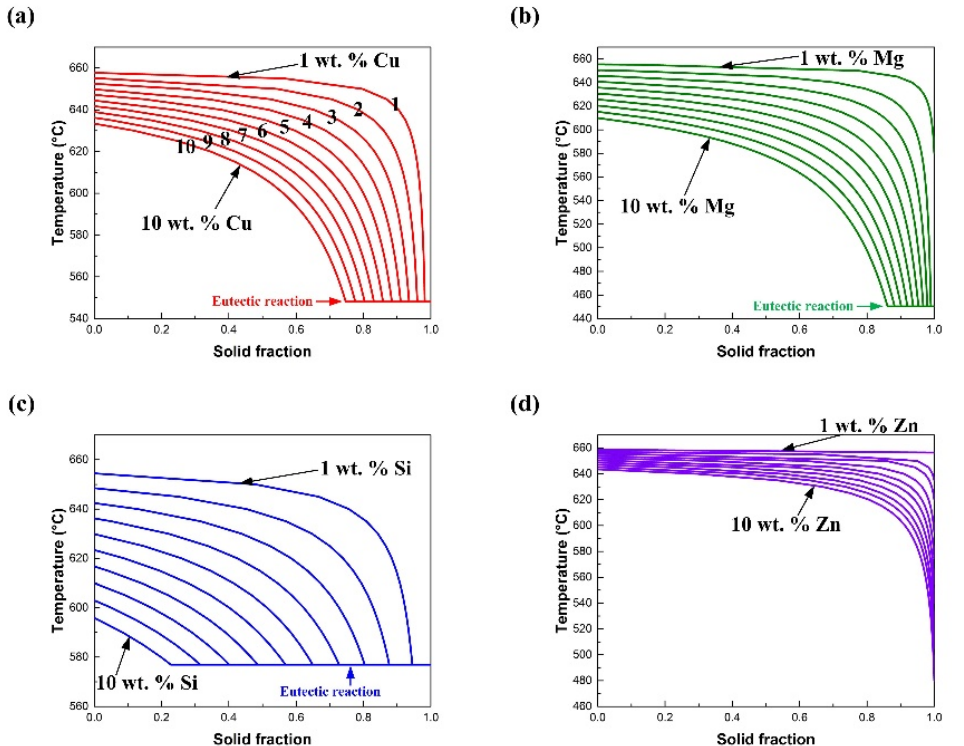
Figure 4. Assessment of each alloying element on the solidification path: ( a ) Al-Cu binary system; ( b ) Al-Mg binary system; ( c ) Al-Si binary system; ( d ) Al-Zn binary ( b ) Al-Mg binary system; ( c ) Al-Si binary system; ( d ) Al-Zn binary system.